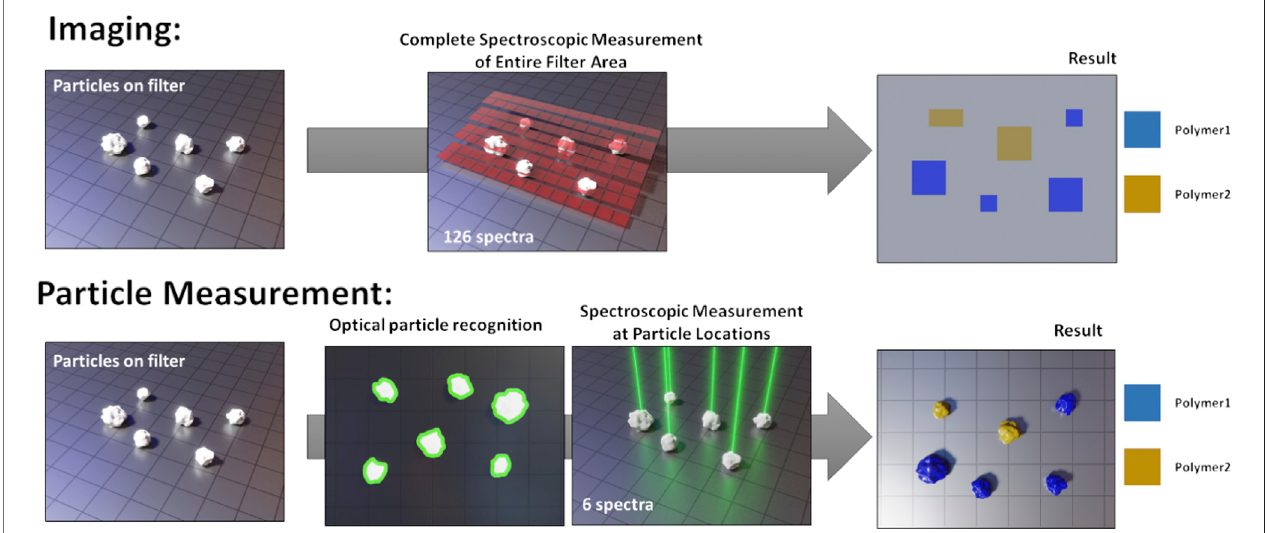
FIGURE 1 | Schematic comparison of spectroscopic imaging and particle measurement. Reproduced from Brandt et al. (2020).